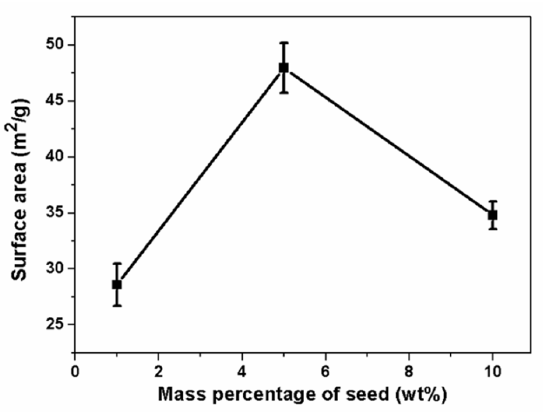
Figure 5. Specific surface area of the hydrothermal powders with different mass percentages of seeds treated at 230 °C.